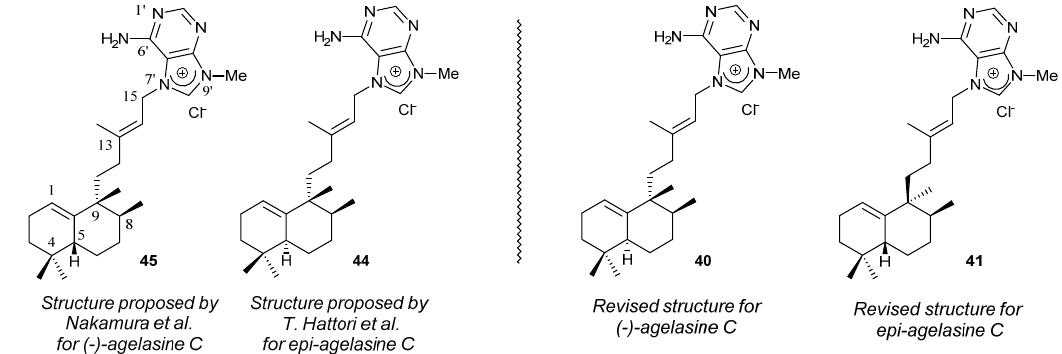
Figure 10. Structure proposed and revised for ( − )-agelasine C and epi-agelasine C.